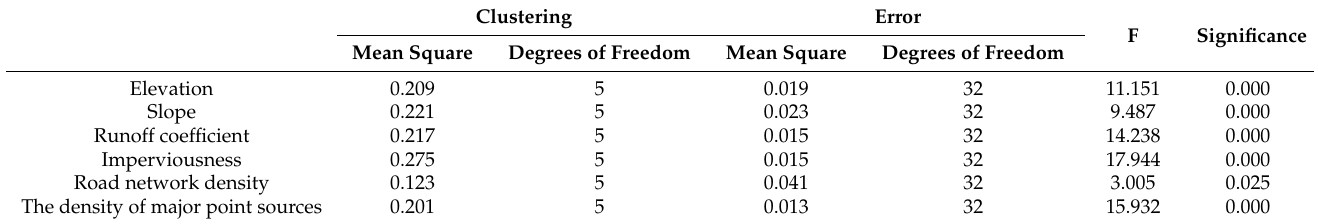
Table 4. Difference comparison results of a cluster category analysis of